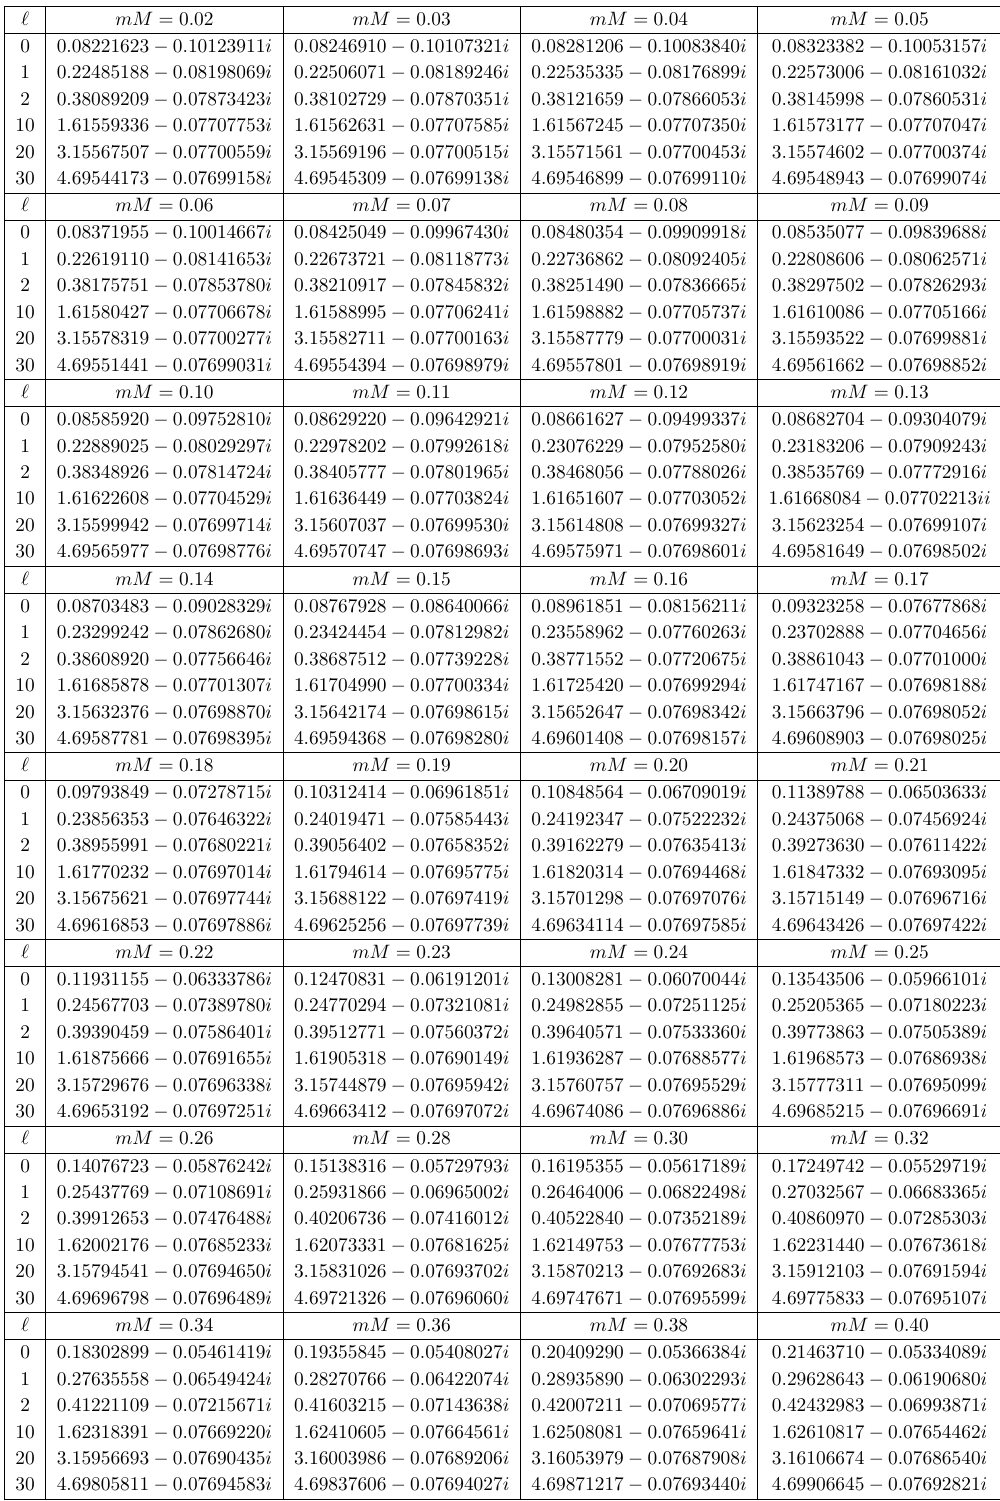
Table 3 . Dominant photon sphere modes ( n PS = 0) for massive scalar (cid:12)elds with ‘ = 0 ; 1 ; 2 ; 10 ; 20, and 30 in the background of a Schwarzschild-de Sitter black hole with M 2 (cid:3) = 0 : 04.